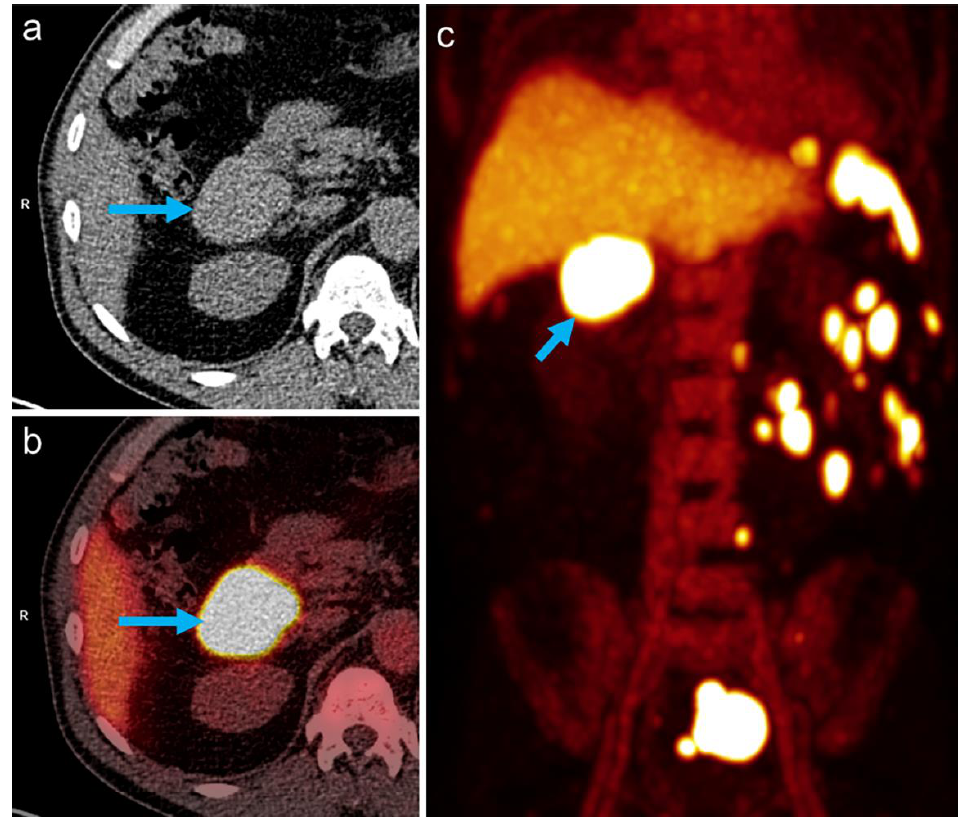
Figure 2. Multiple masses with high tracer uptake seen on RBC-PET/CT (( a ): non-contrast CT, ( b ): PET/CT fusion, ( c ): PET maximum intensity projection (MIP) image acquired 25 min after tracer injec- tion).